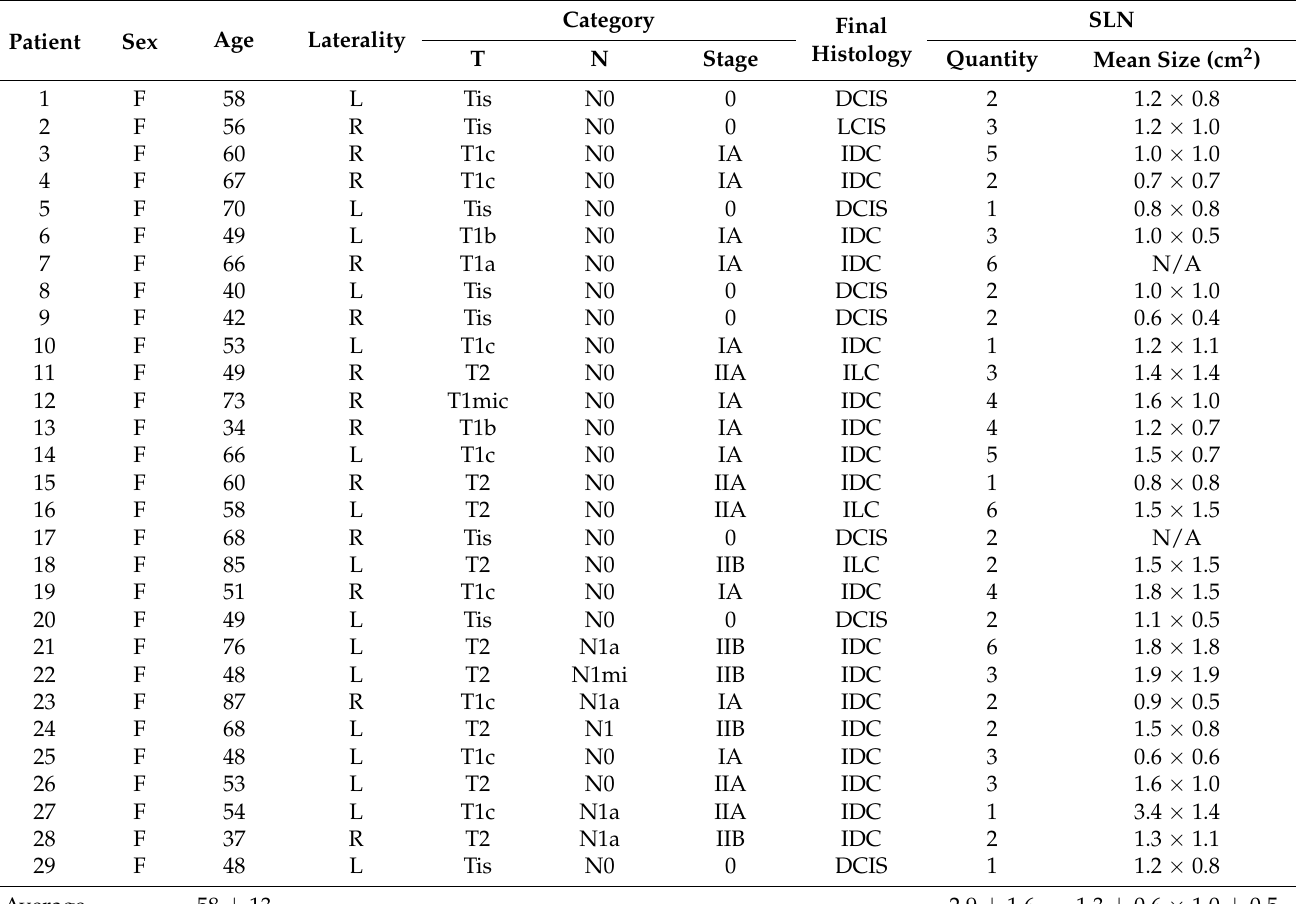
Table 1. Characteristics of 29 patients with BC whose SLNs were collected for FS